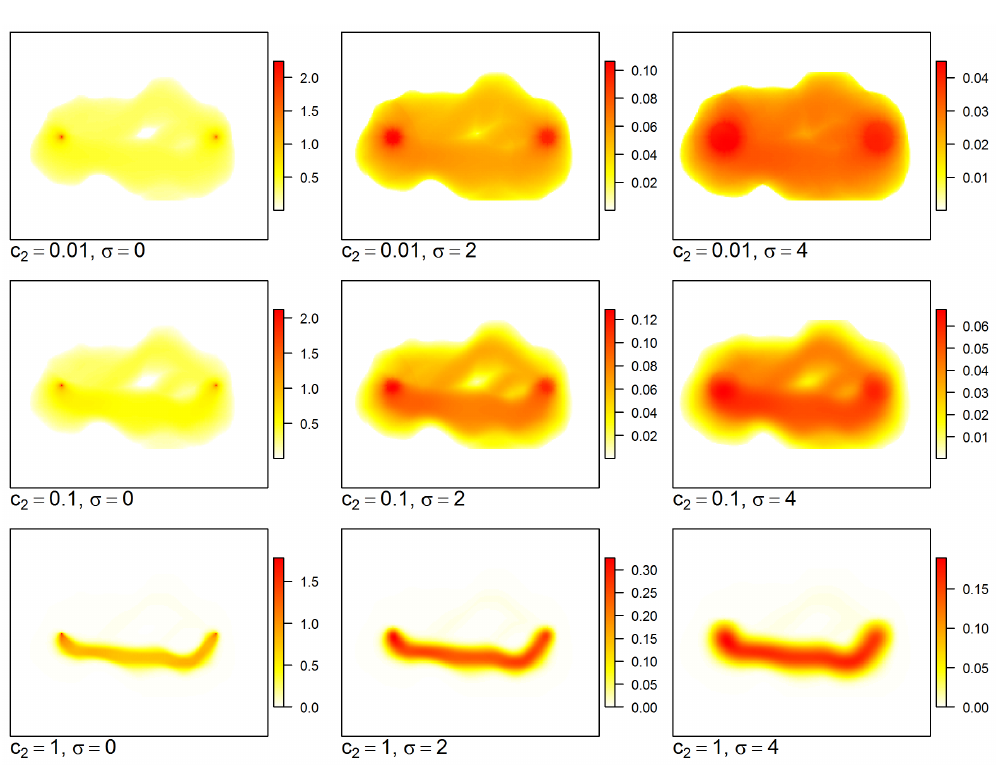
Figure 7: Output probability surfaces ( P i ) for different values of the tuning parameter c 2 and locational uncertainty parameter σ using the exponential model applied to Scenario